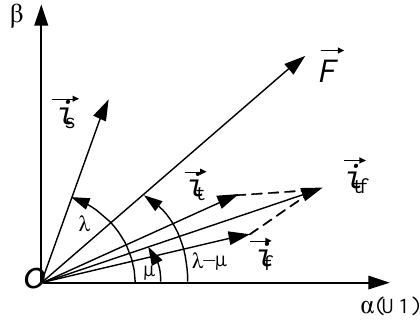
Figure 6. Diagram of the suspension force vector and current vector.